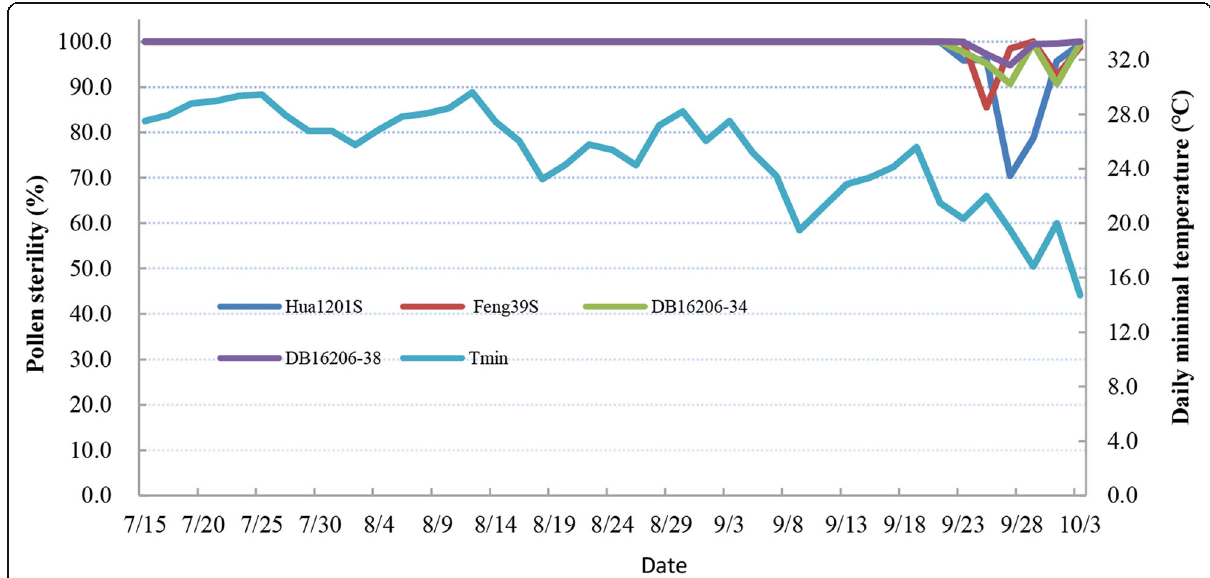
Fig. 4 Pollen fertility dynamic performance of selected breeding PTGMS lines and parents in the summer season of 2018 in